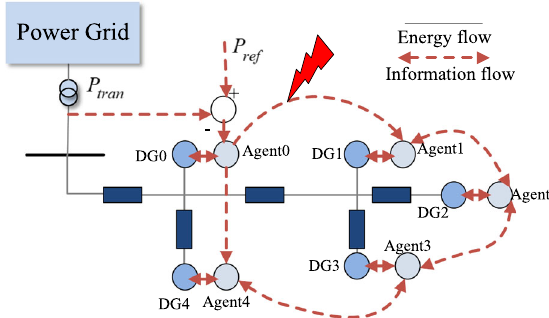
Fig. 7 Illustrative diagram of distributed control of distributed